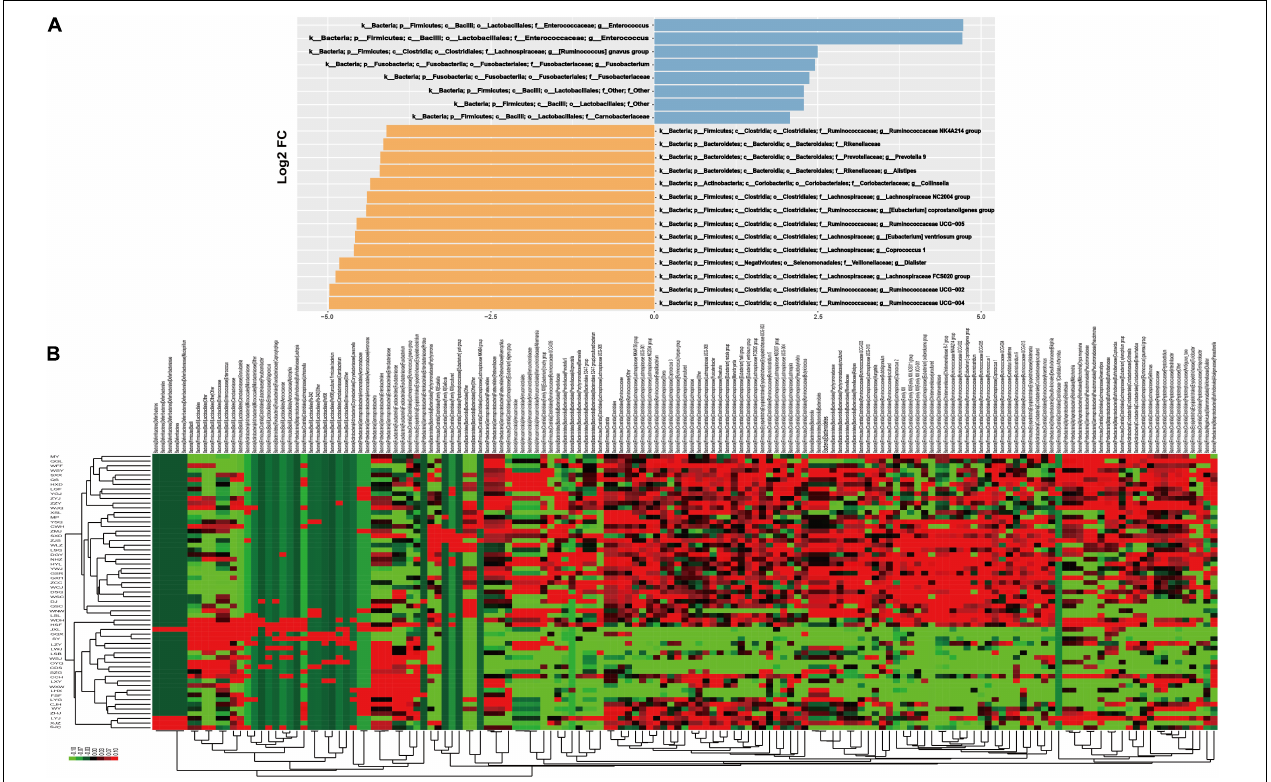
FIGURE 3 | The results of differential taxonomy expression analysis using limma algorithm. Panel (A) shows the differential taxonomy expression in the CHF patients vs. healthy control group; (B) shows the differential taxonomy expression in every